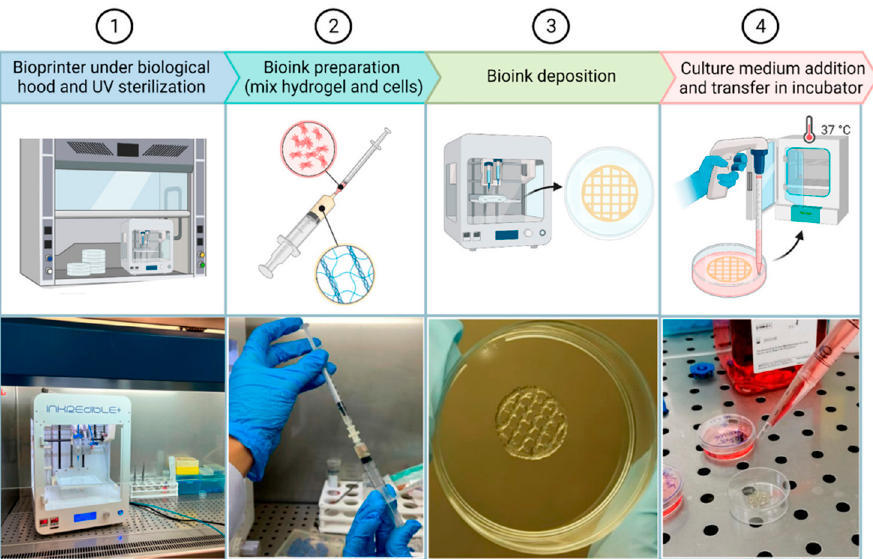
Figure 6. Three-dimensional bioprinting procedure. It starts with (1) the positioning of the bi- oprinter under a biological hood and UV light sterilization. (2) Next, bioink is prepared by mixing cells and hydrogel, and (3) printing finally takes place. (4) Culture medium is added, and 3D struc- tures are placed inside the incubator. (reprinted with permission from